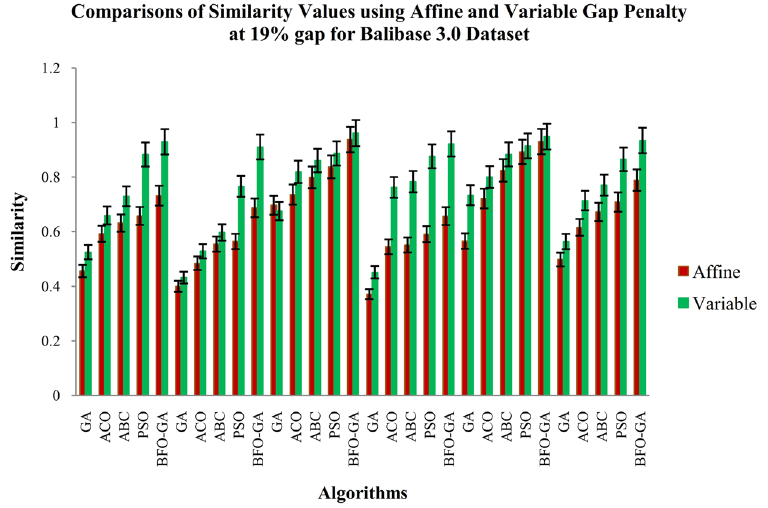
Figure 3. Comparisons of Similarity values for BAliBASE datasets using Affine and Variable Gap penalty for the proposed and existing